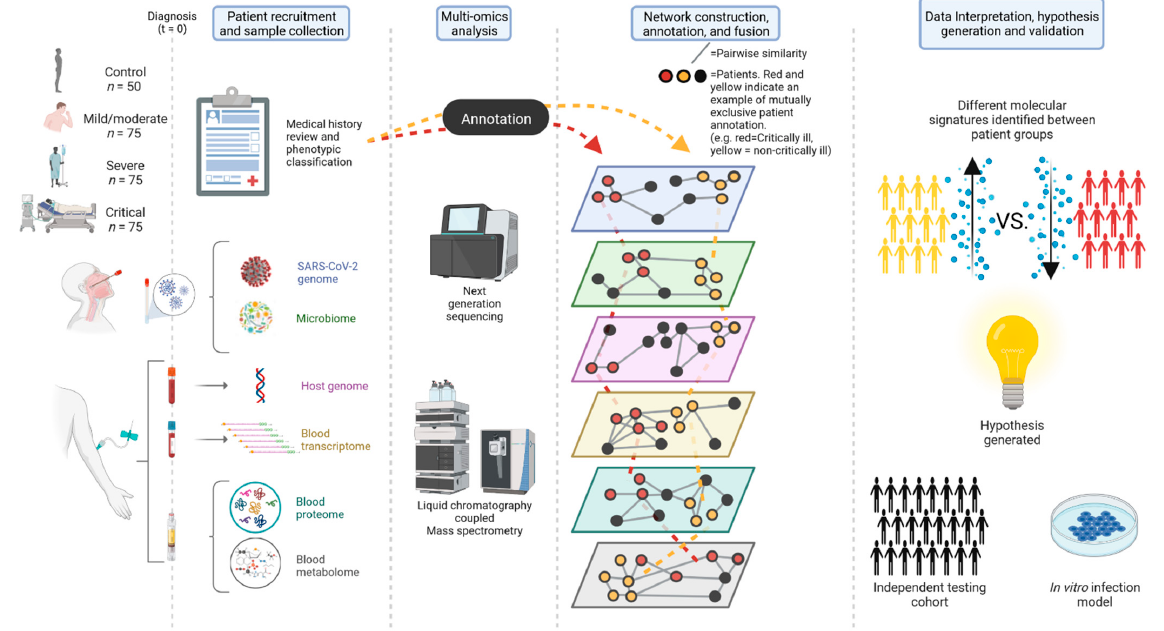
Figure 1. General scheme of the study, from patient recruitment at diagnosis, to -omics analysis, network fusion, data interpretation, and finally hypothesis generation and validation (through cohorts or infection models). (Created with BioRender.com©).